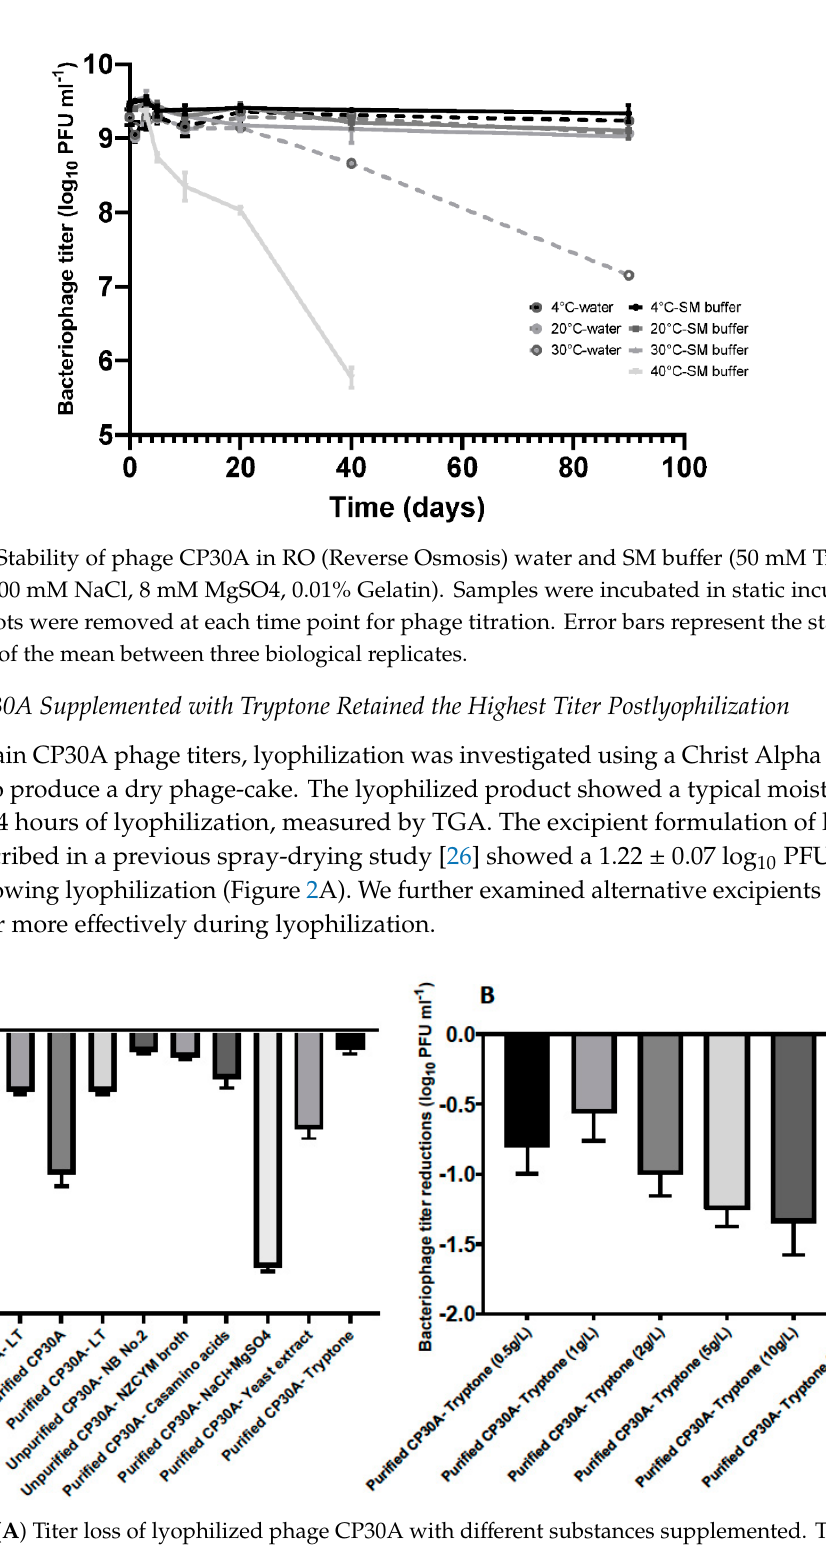
Figure 1. Stability of phage CP30A in RO (Reverse Osmosis) water and SM buffer (50 mM Tris.HCl (pH7.5), 100 mM NaCl, 8 mM MgSO4, 0.01% Gelatin). Samples were incubated in static incubators and aliquots were removed at each time point for phage titration. Error bars represent the standard deviation of the mean between three biological replicates.